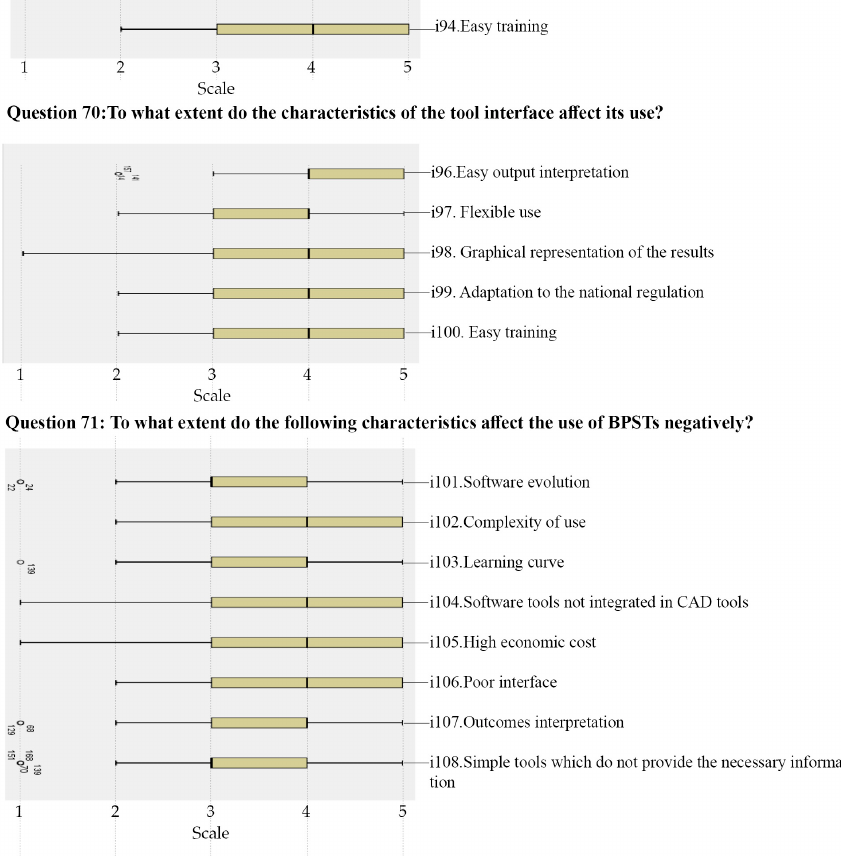
Figure 5. Relevant parameters and characteristics that lead to select BPSTs. 1 “Not at all important,” 2 “Slightly Important,” 3 “Important,” 4 “Fairly Important,” and 5 “Very